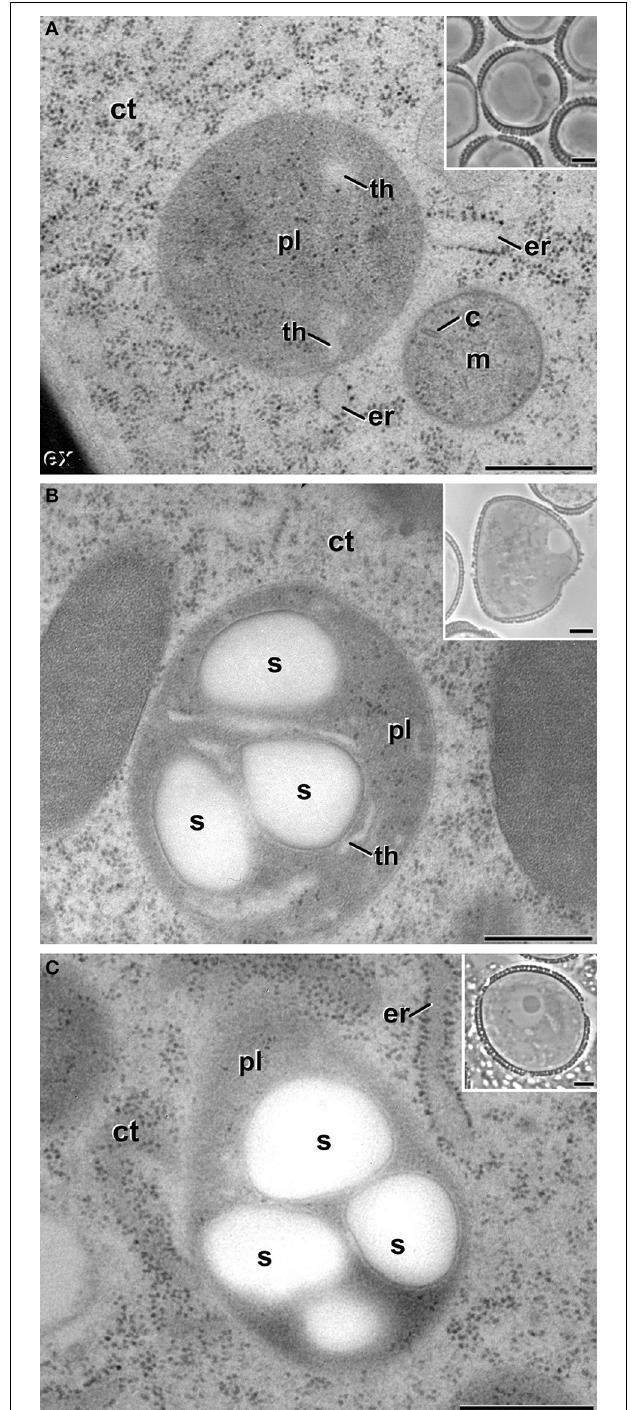
FIGURE 2 | Plastids (pl) of non-embryogenic B. napus cells. (A) Proplastid of a vacuolate microspore during in vivo development within the anther. (B) Amyloplast of an in vitro cultured, pollen-like structure. (C) Amyloplast of a pollen grain within the anther. Insets show light microscopy sections of the corresponding stages. (C) , mitochondrial crista; ct, cytoplasm; er, endoplasmic reticulum; ex, exine; m, mitochondria; s, starch; th, thylakoid. Bars: 500nm, insets: 5 μ